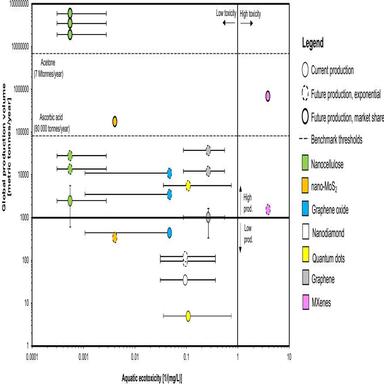
Results from using two proxy measures (global annual production volume and aquatic ecotoxicity) on seven advanced nanomaterials. Error bars show 25th and 75th percentiles. The 1 L/mg threshold is a European CLP regulation criterion for acute aquatic toxicity. The 1000 t/year threshold marks high-volume chemicals according to the. Number of aquatic ecotoxicity data points: 20 for nanocellulose, 2 for nano-MoS2, 5 for graphene oxide, 5 for nanodiamond, 33 for quantum dots, 4 for graphene, and 1 fo